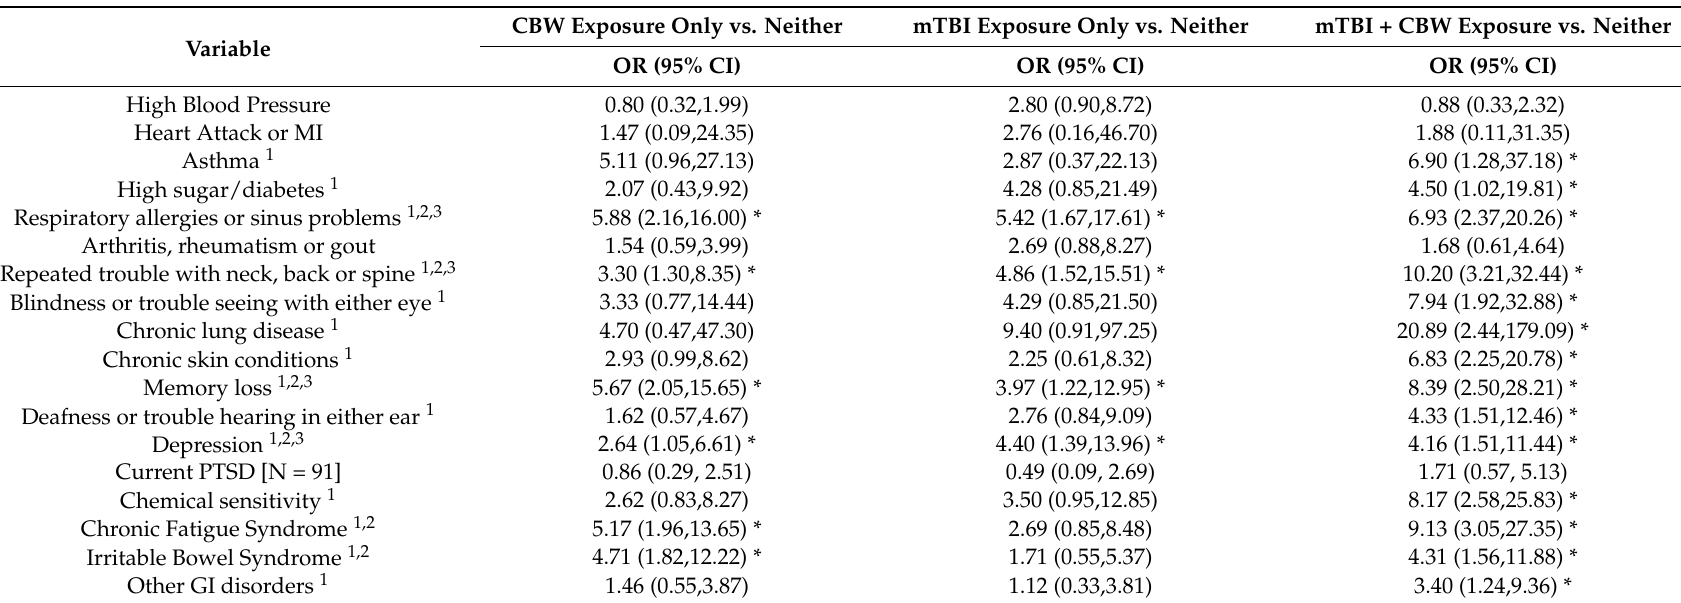
Table 3. Unadjusted logistic regression analysis examining CBW exposure, mTBI exposure, and mTBI +